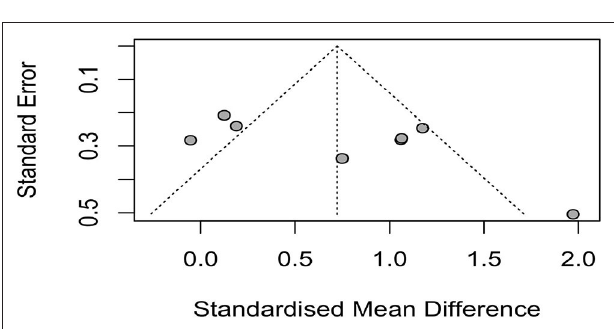
FIGURE 4 | The funnel plot. K = 8, The Egger’s test for publication bias: t = 1.7856, df = 6, p =